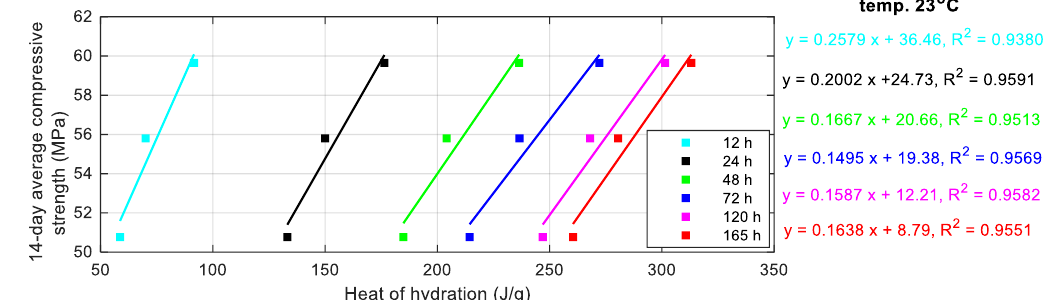
Figure 10. Correlation of 14-day strength and heat of mortars cured at 23 °C.